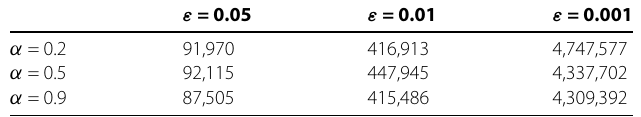
Table 3 The posteriori regularization parameter m under different α and ε for Example 3 ε = 0.05 ε = 0.01 ε = 0.001 α = 0.2